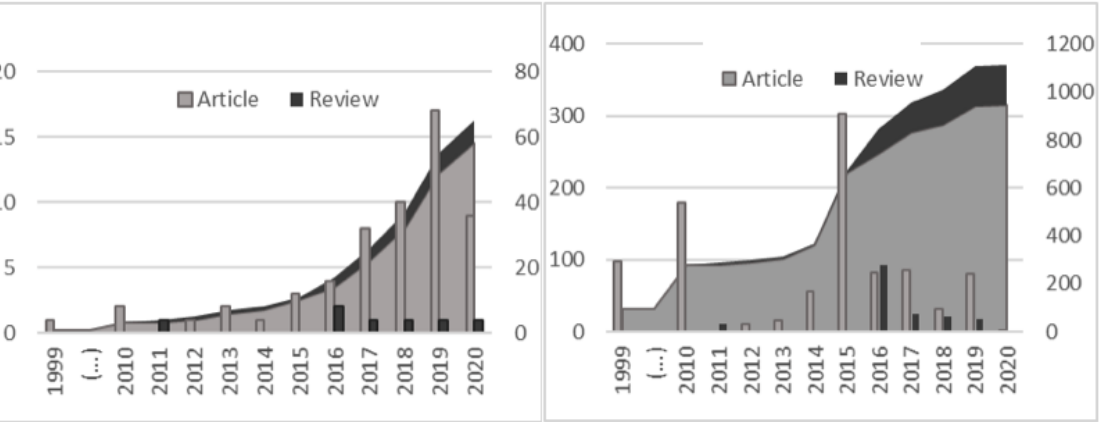
Figure 6. The annual and accumulated global evolution of publications and citations (research arti- cles and review studies) concerning public policies on renewable energies from the perspective of the CE.